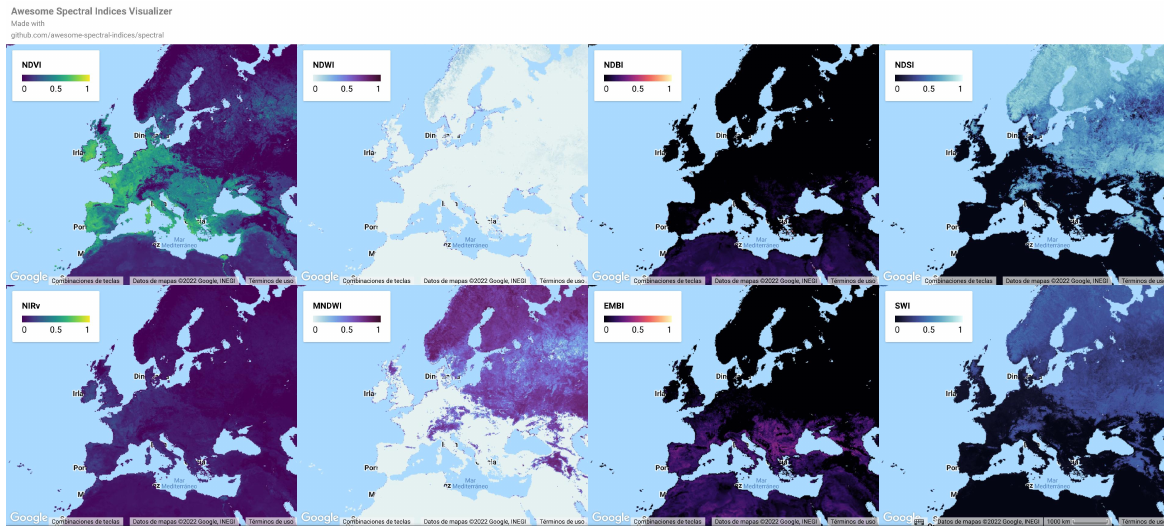
Figure 2. Screenshot of the Awesome Spectral Indices Visualizer App. Column 1 shows vegetation indices: NDVI and NIRv. Column 2 shows water indices: NDWI and MNDWI. Column 3 shows urban and bareness indices: NDBI and EMBI. Column 4 shows snow indices: NDSI and